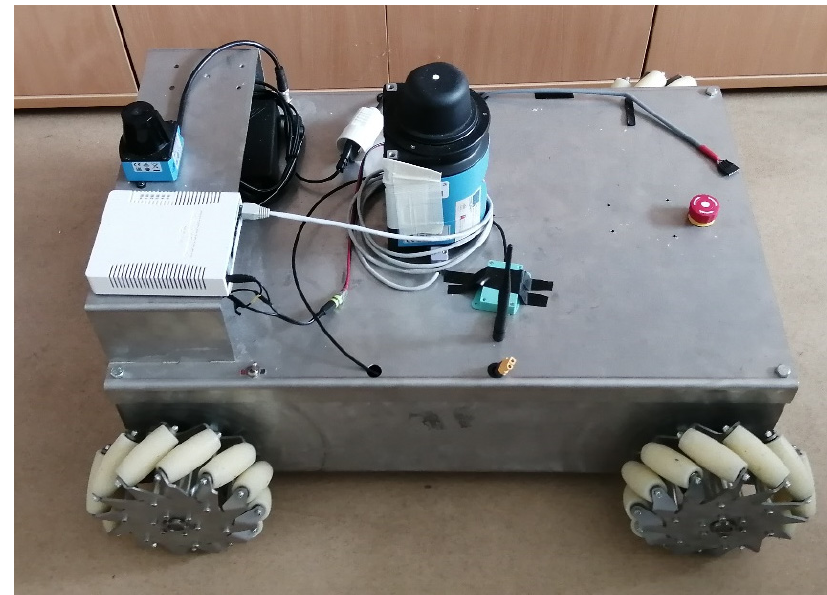
Figure 4. Mobile robotic system.